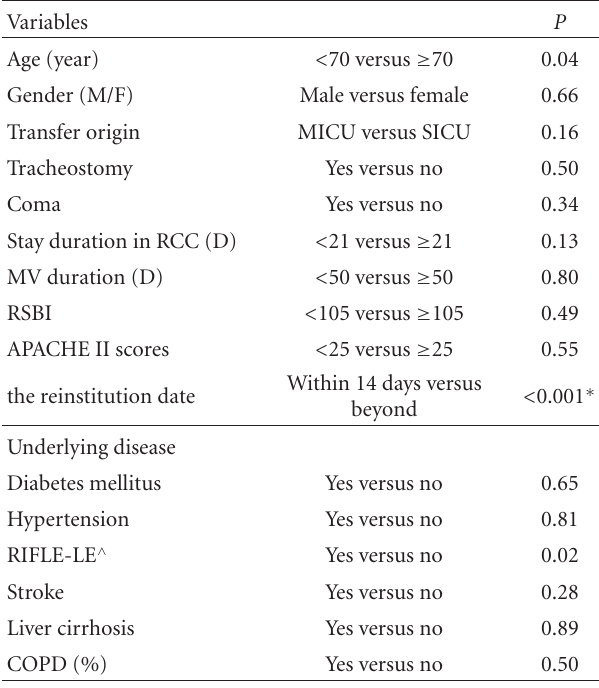
Table 2: Prognostic factors of 1-year mortality in prolonged mech- anical ventilation patients with successful weaning by univariate and multivariate